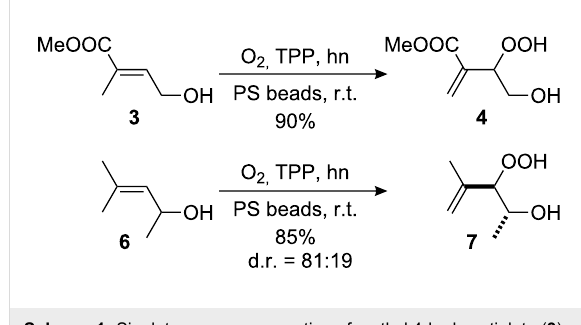
Results and Discussion 3,3-Spiroannulated 1,2,4-trioxanes The photooxygenation reactions via sensitization of triplet oxygen with meso -tetraphenylporphyrin (TPP) were performed in polystyrene beads under solvent-free conditions (Scheme 1)